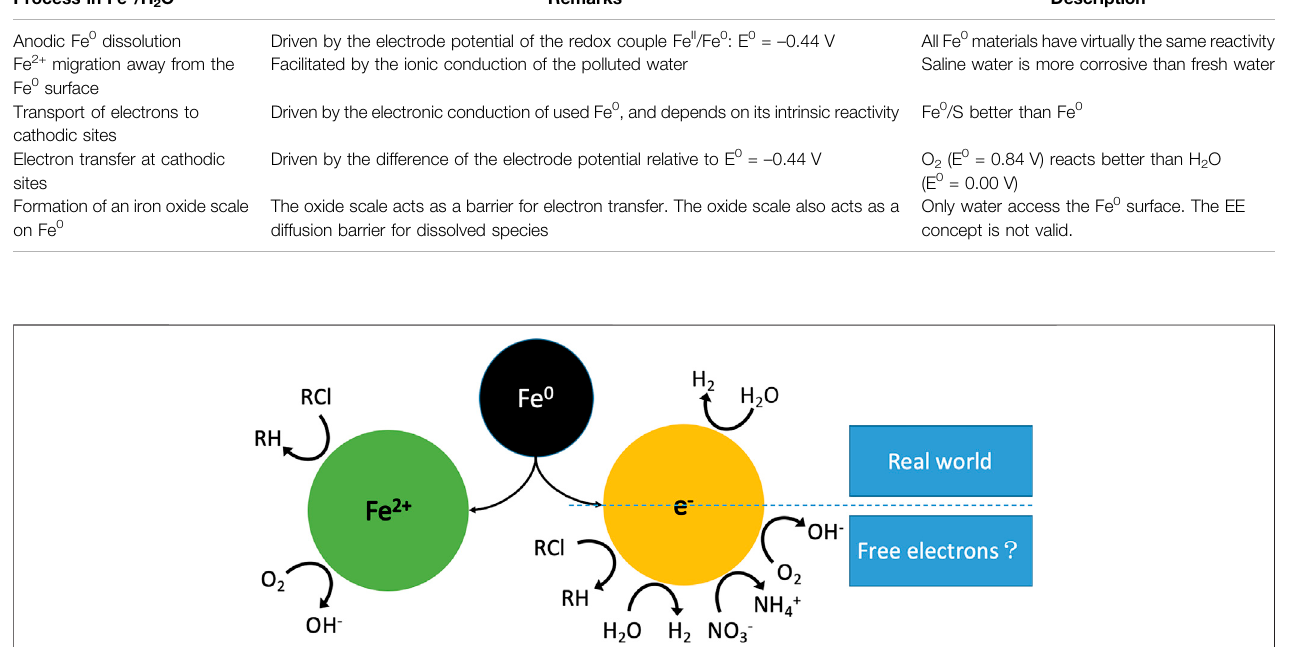
TABLE 4 | Summary of the key factors affecting changes in Fe 0 /H 2 O systems and their implication for the validity of the electron ef fi ciency concept (EE concept). Process in Fe 0 /H 2 O